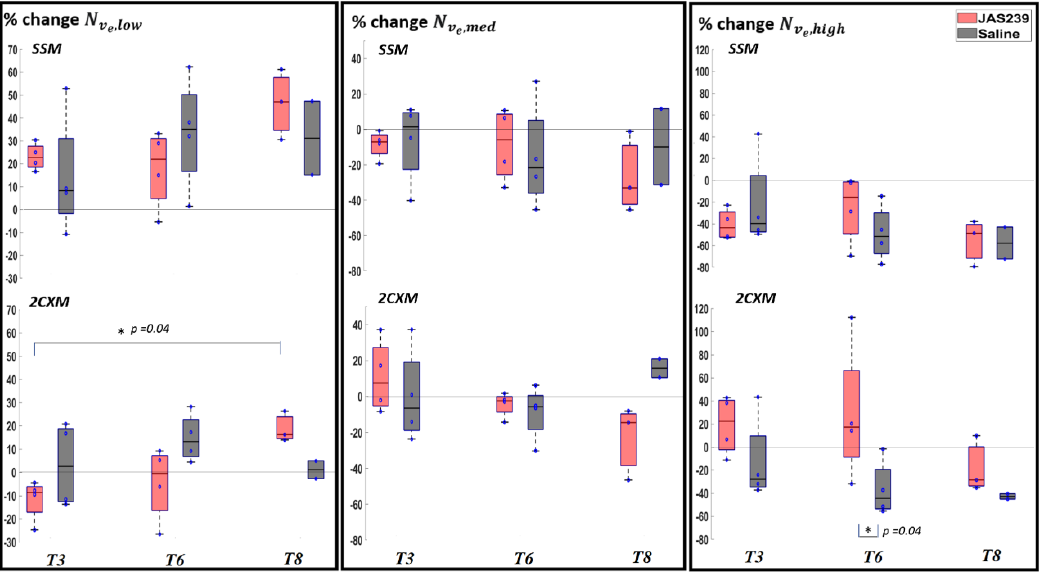
Figure 7. Box plot for percentage change (with respect to baseline) in 𝑁 𝑣 and high) in F98 rat GBM with JAS239 (red) and saline (grey) treatment at different time points using the SSM (top) and 2CXM (bottom) models, respectively. The asterisk indicates significant difference. No significant change or trend was noticed for the GL261 mice treated with JAS239 (Figures 5 and